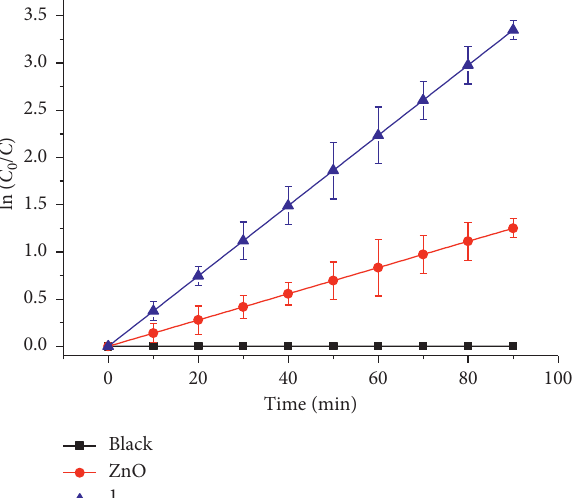
Figure 27: Ln(C) 0 /(C) plotted as a function of the degradation time ( t ) for various samples subjected to UV light irradiation (1: ZnO/ sepiolite composites).